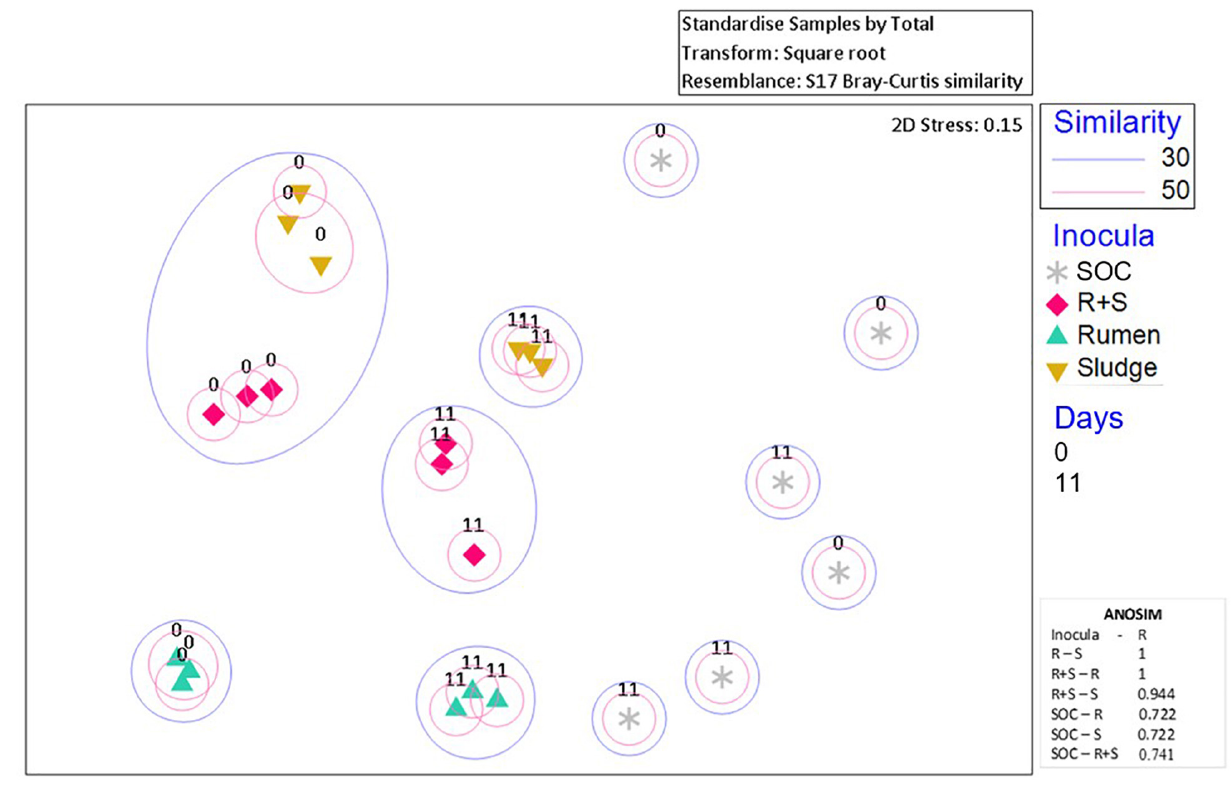
FIGURE 4 | nMDS plot of incubation communities at the time zero (denoted by “0”) and the time of maximal EtOH production (denoted by “11”). Blue or pink circles encompass communities which share 30 and 50% similarities, respectively. The 2D stress value indicates good representation of the data on these 2D nMDS plots. ANOSIM R values (0.1% significance level) range from 0 to 1 where 1 = high dissimilarity between clusters. R, rumen pH 7; S, sludge pH 5.5; R + S, mixed-source community pH 5.5; SOC, substrate only